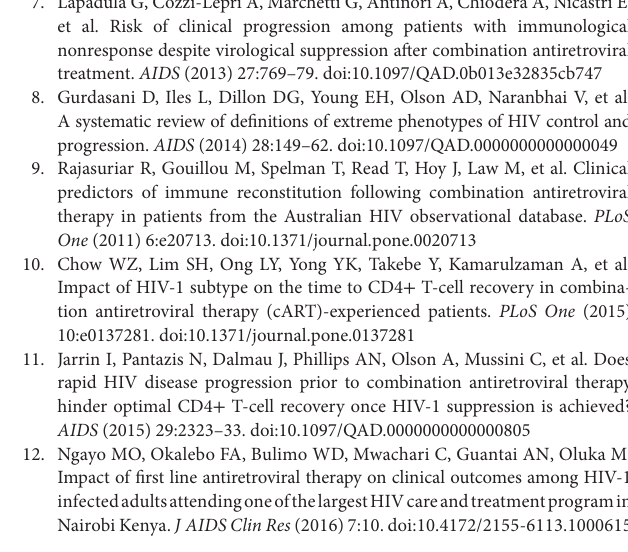
FigUre s1 | Gaiting strategy used to analyse CD4+ T cell populations phenotypically distinct by their CD57 and CD28 surface expression (a , B) . Glut1 MFI expression in CD4+ T cells with naïve (CD57–CD28+), activated (CD57+CD28+) and senescent phenotypes (CD57+CD28–) (c) . Gaiting strategy used to analyse CD4+PD1– and CD4+PD1+ T cell populations (D) . Glut1 MFI expression in CD4+ T cells with normal (CD4+PD1–) and exhausted (CD4+PD1+) phenotypes (e) . FigUre s2 | Genotypes and the distribution of favorable and non-favorable CD4+Glut1+ T cell percentages in HIV-positive individuals with SLC2A1 SNP rs1385129 (a) , and SLC2A1-AS1 SNP rs710218 (B) . SNP = Single nucleotide